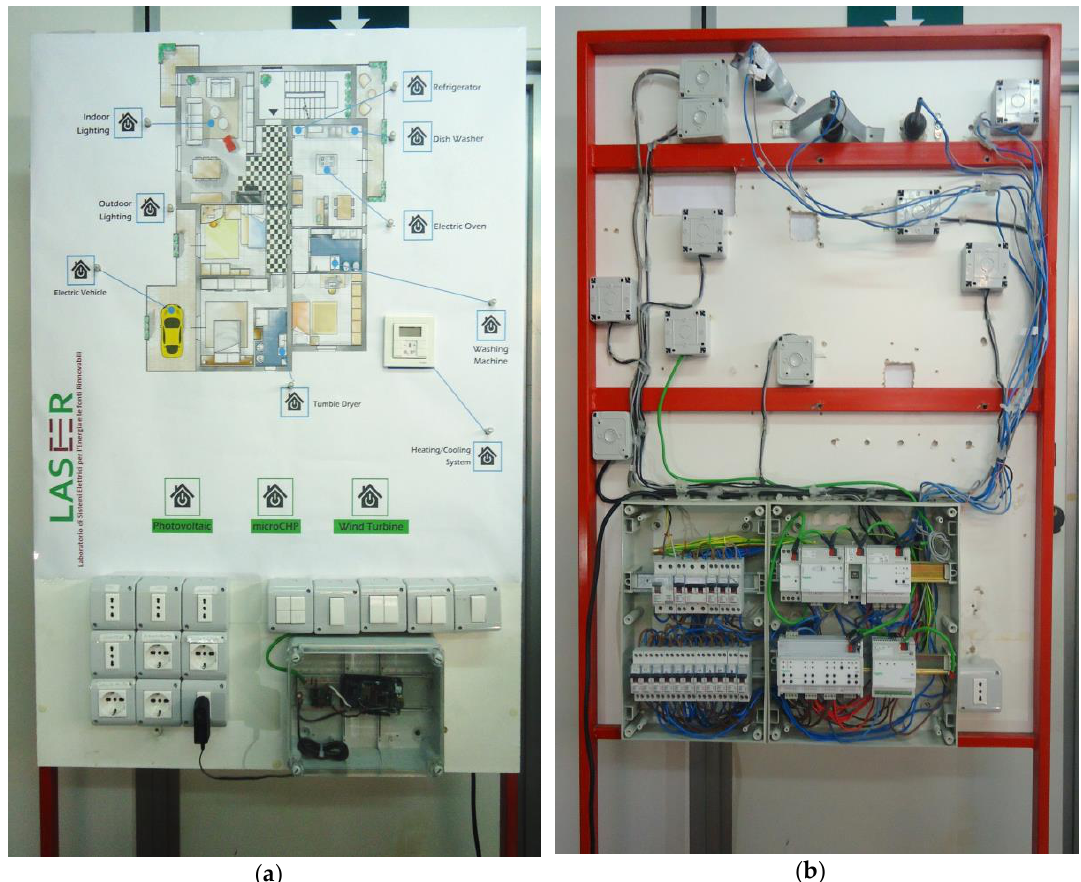
Figure 7. Front-side ( a ) and rear-side ( b ) of the demonstration home automation panel.